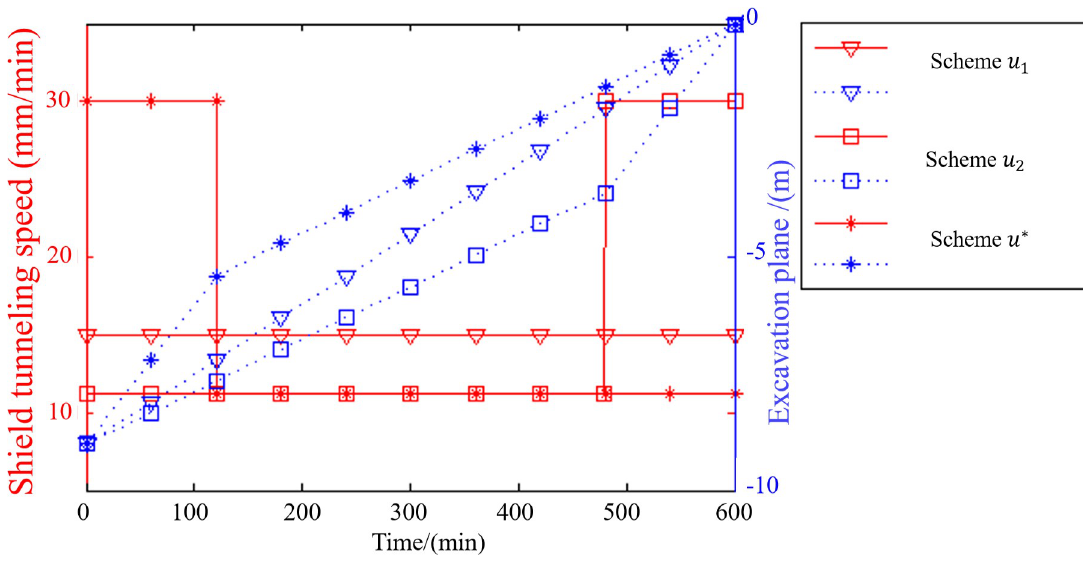
Fig 7. Comparison of different shield tunneling schemes.